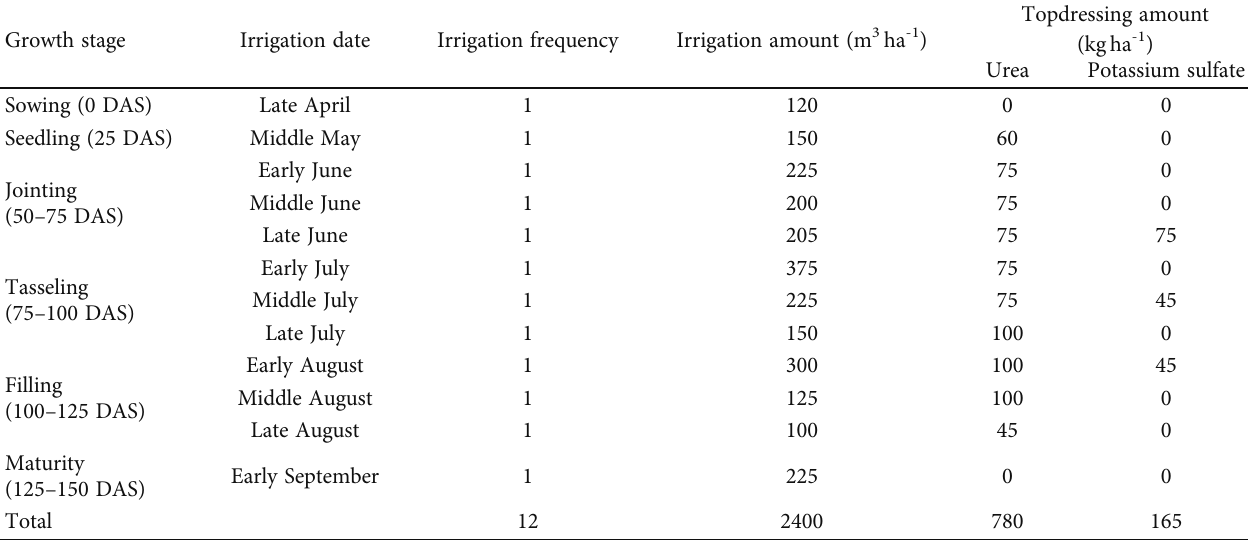
Table 2: Irrigation water and fertilizer applications during the maize growing